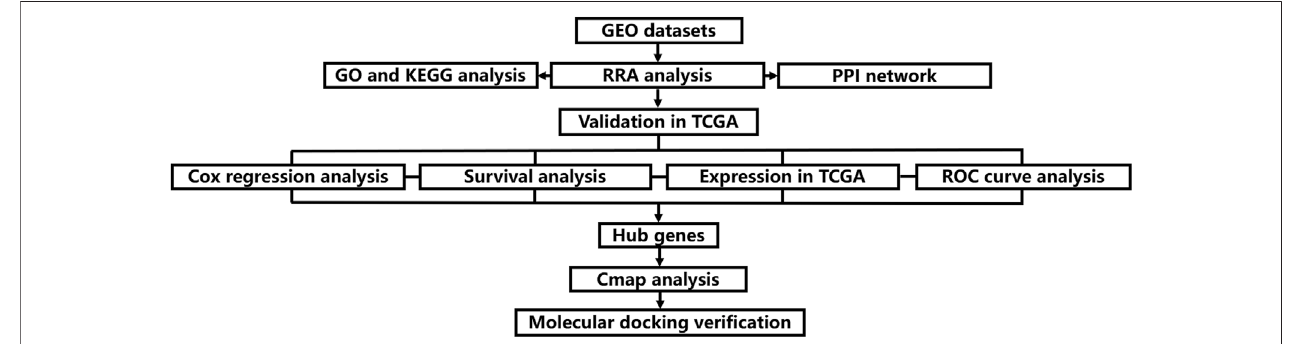
FIGURE 1 | Flow chart of the present